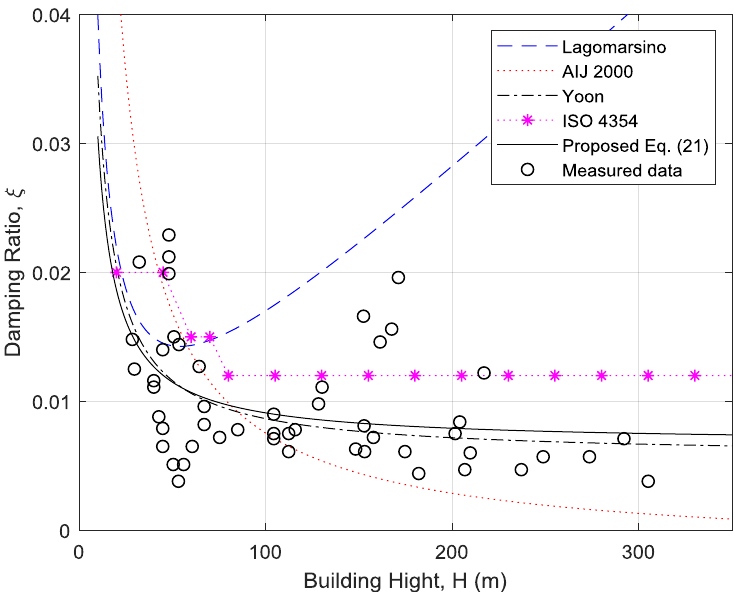
Figure 11. Comparison of proposed equation for estimating damping ratio with various empirical formulae—only the frequency-dependent term is included.